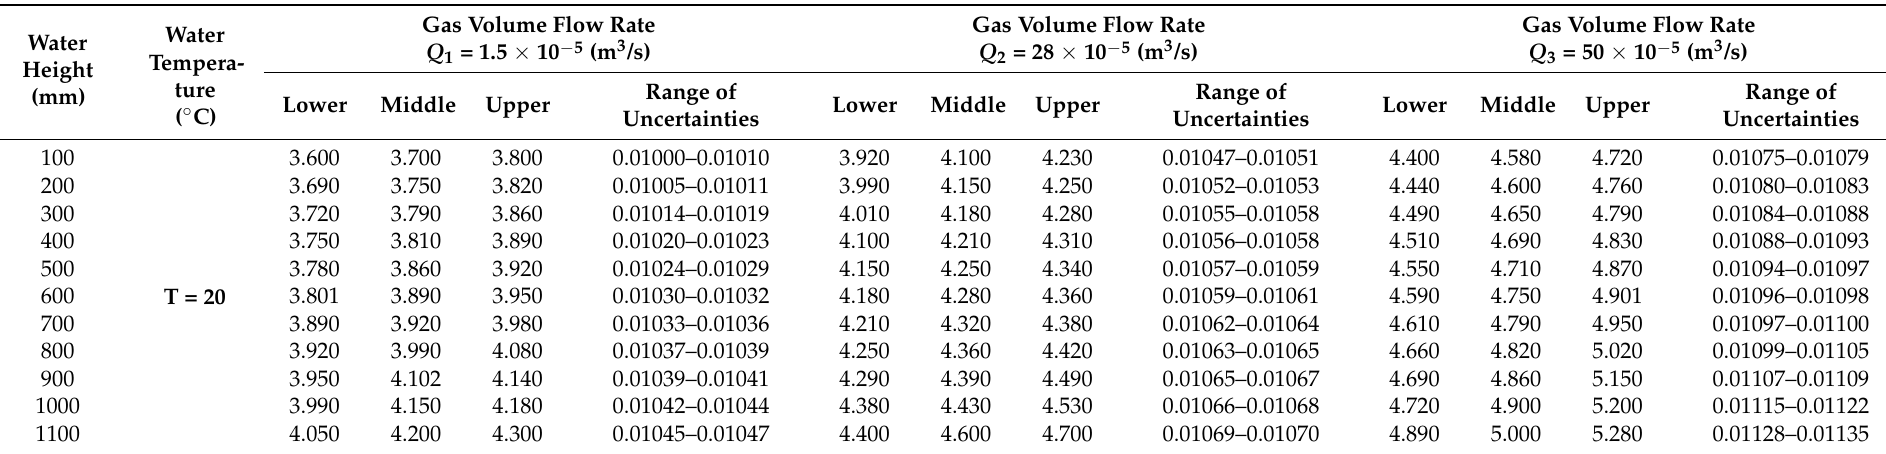
Table 2. Bubble diameter (mm) as a function of water height for T = 20 ◦ C and for gas volume flow rates Q 1 –Q 3 .